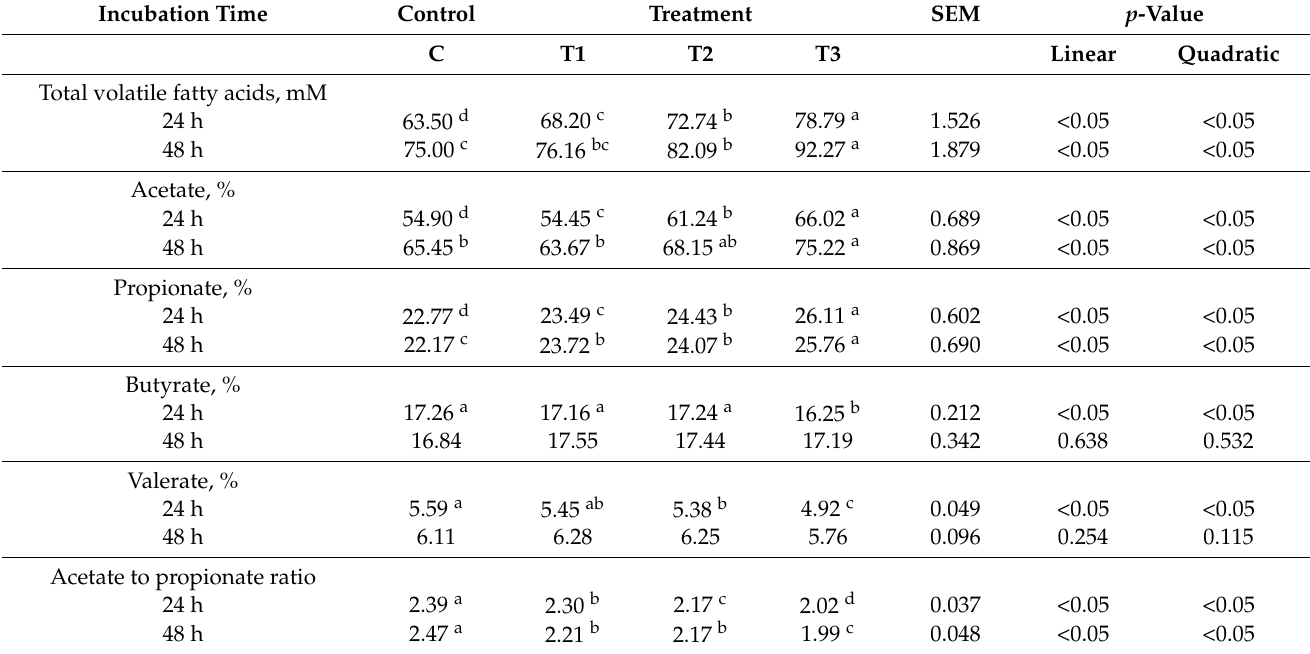
Table 3. Effects of supplemental resveratrol on volatile fatty acid levels in in vitro ruminal fermentation.